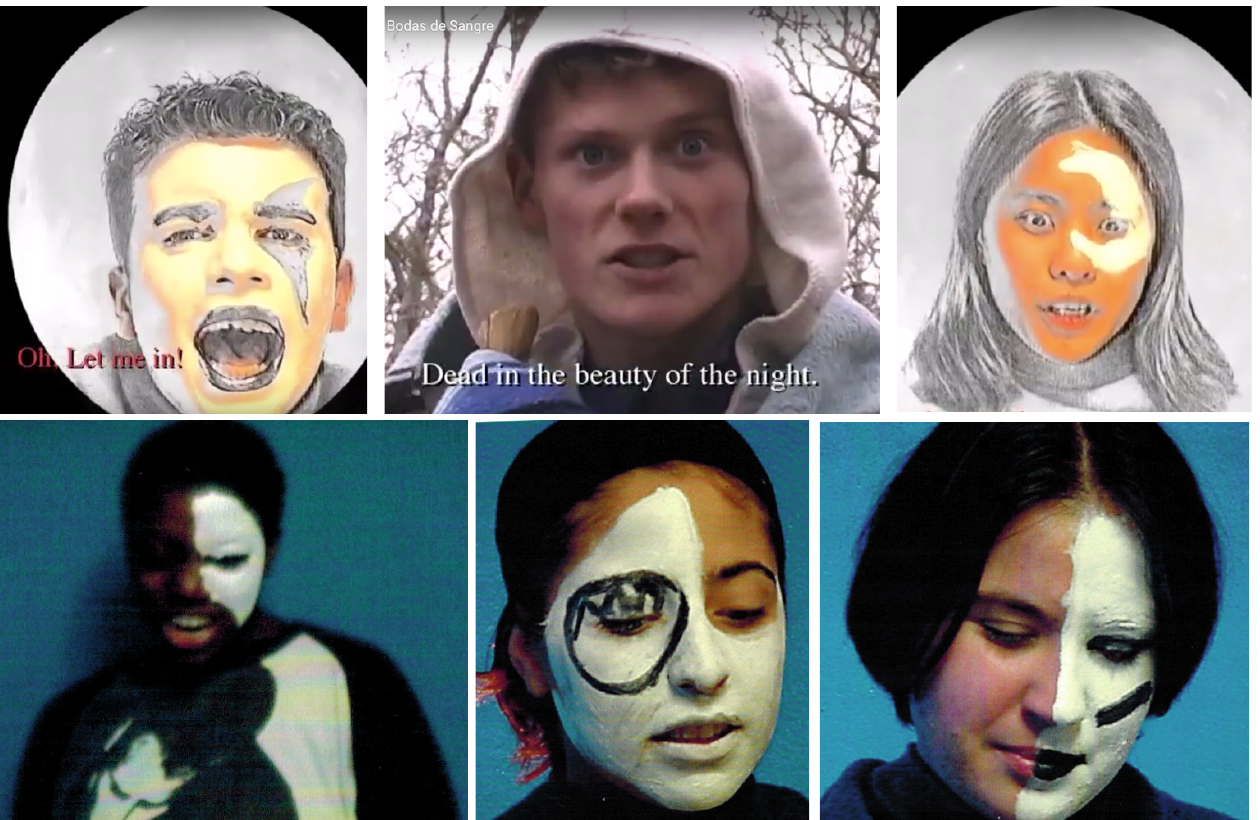
TOP LEFT: RODRIGO – LA LUNA / THE MOON TOP CENTER: LUKE – EL MENDIGO / THE BEGGAR TOP RIGHT: KIM – VIETNAMESE MOON BOTTOM LEFT: ASOKA- YORUBA MOON BOTTOM CENTER: LUISINA -ARGENTINEAN MOON BOTTOM RIGHT: EBRU – TURKISH